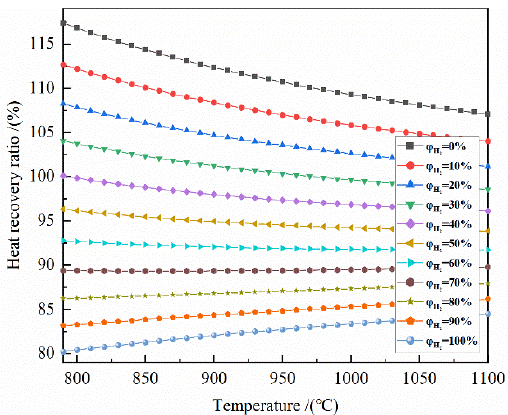
Figure 8. The effect of reduction temperature on the heat recovery rate of the reduction of 0.5 mol Fe 2 O 3 at 790–1100 ◦ C with varied H 2 concentrations.